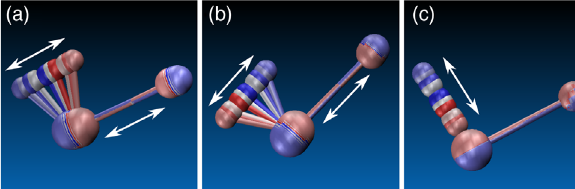
FIG. 5. Normal modes for CaSH corresponding to (a) 316 cm − 1 , (b) 360 cm − 1 , and (c) 2640 cm − 1 vibrational frequencies. The beginning of the trajectory is indicated in red, the middle in white, and the end in blue. Note the strong mixing between the bending motion and Ca-S stretching